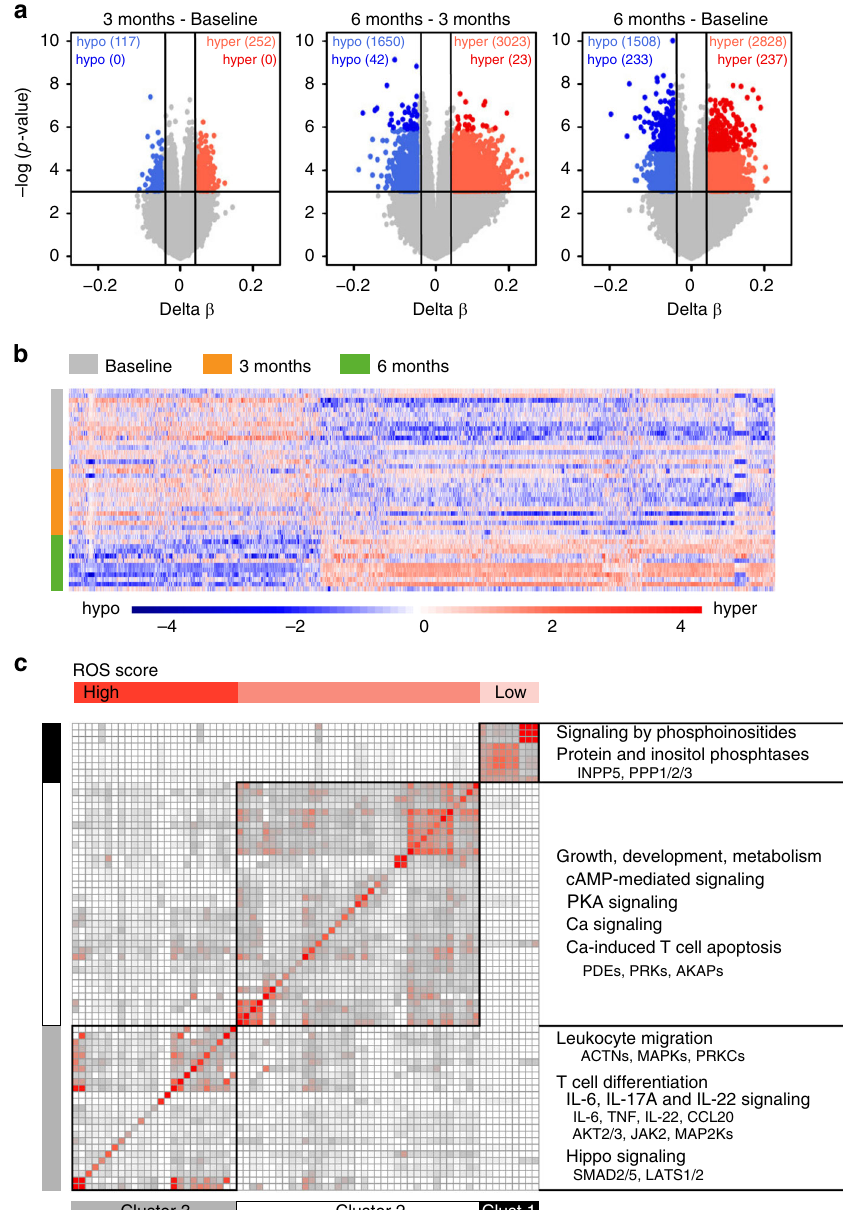
Fig. 5 DNA methylation changes are delayed in T cells and occur after six months. a DNA methylation was measured using Illumina EPIC arrays in CD4 + T cells sorted from peripheral blood of RRMS patients before (baseline; BL, n = 17) treatment with DMF as well as three and six months following the treatment M3 and M6 n = 12). Volcano plots illustrating differences in DNA methylation between different time points following DMF treatment. Hyper- and hypo-methylated CpGs with min 5% methylation change and P < 0.001 (Linear model testing) are indicated in red and blue, respectively. b Heat map of 1614 most signi fi cant differentially methylated CpG sites between the time points (the scale represents z -score). c Clusters of canonical pathways, derived using Ingenuity Pathway Analysis suggest functions that are affected in monocytes following six months of DMF treatment. The heat-map depicts cluster 1 – 3. The signi fi cance of pathways was determined with the right-tailed Fisher ’ s exact test ( P < 0.05) and the clustering was performed on the relative risk for the overlap of molecules between the pathways using Mclust. The horizontal top bar indicates the degree of overlap with selected ROS genes. Summary of the key functions and their constituent genes that displayed changes in DNA methylation upon DMF treatment are given to the